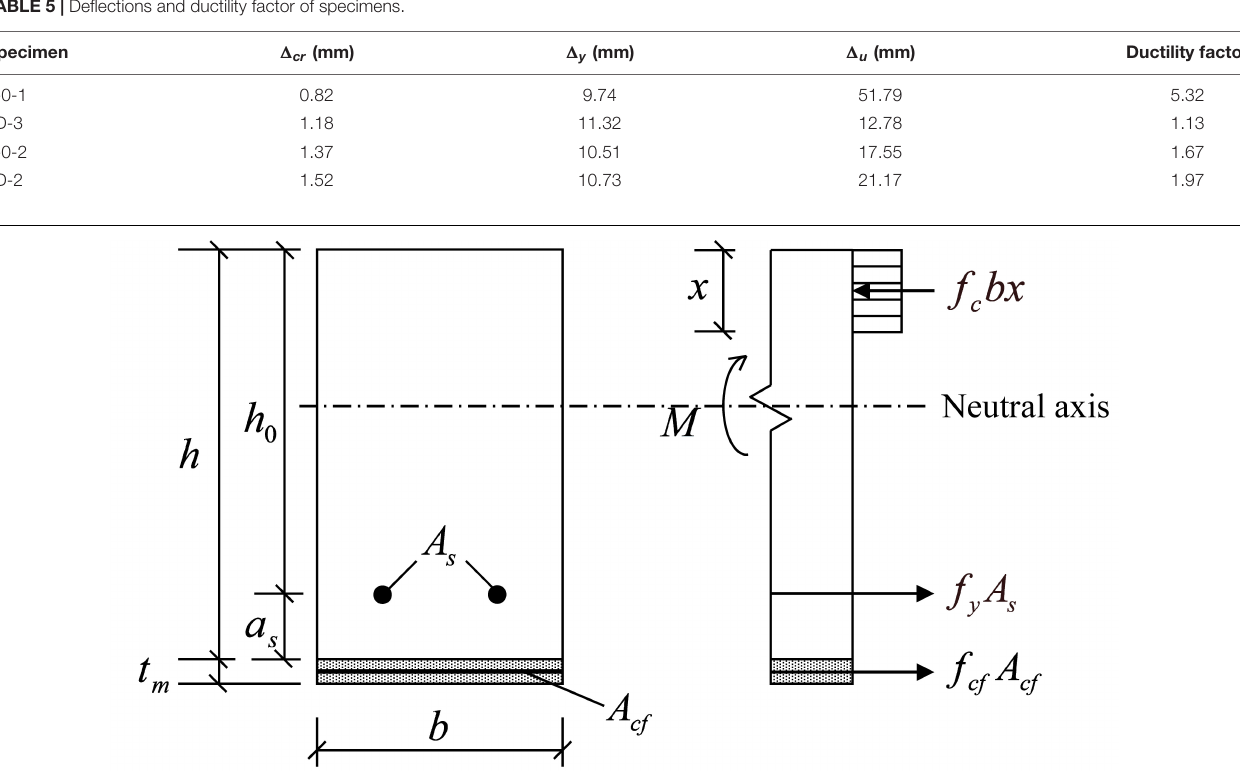
FIGURE 7 | Stress analysis of strengthened beam